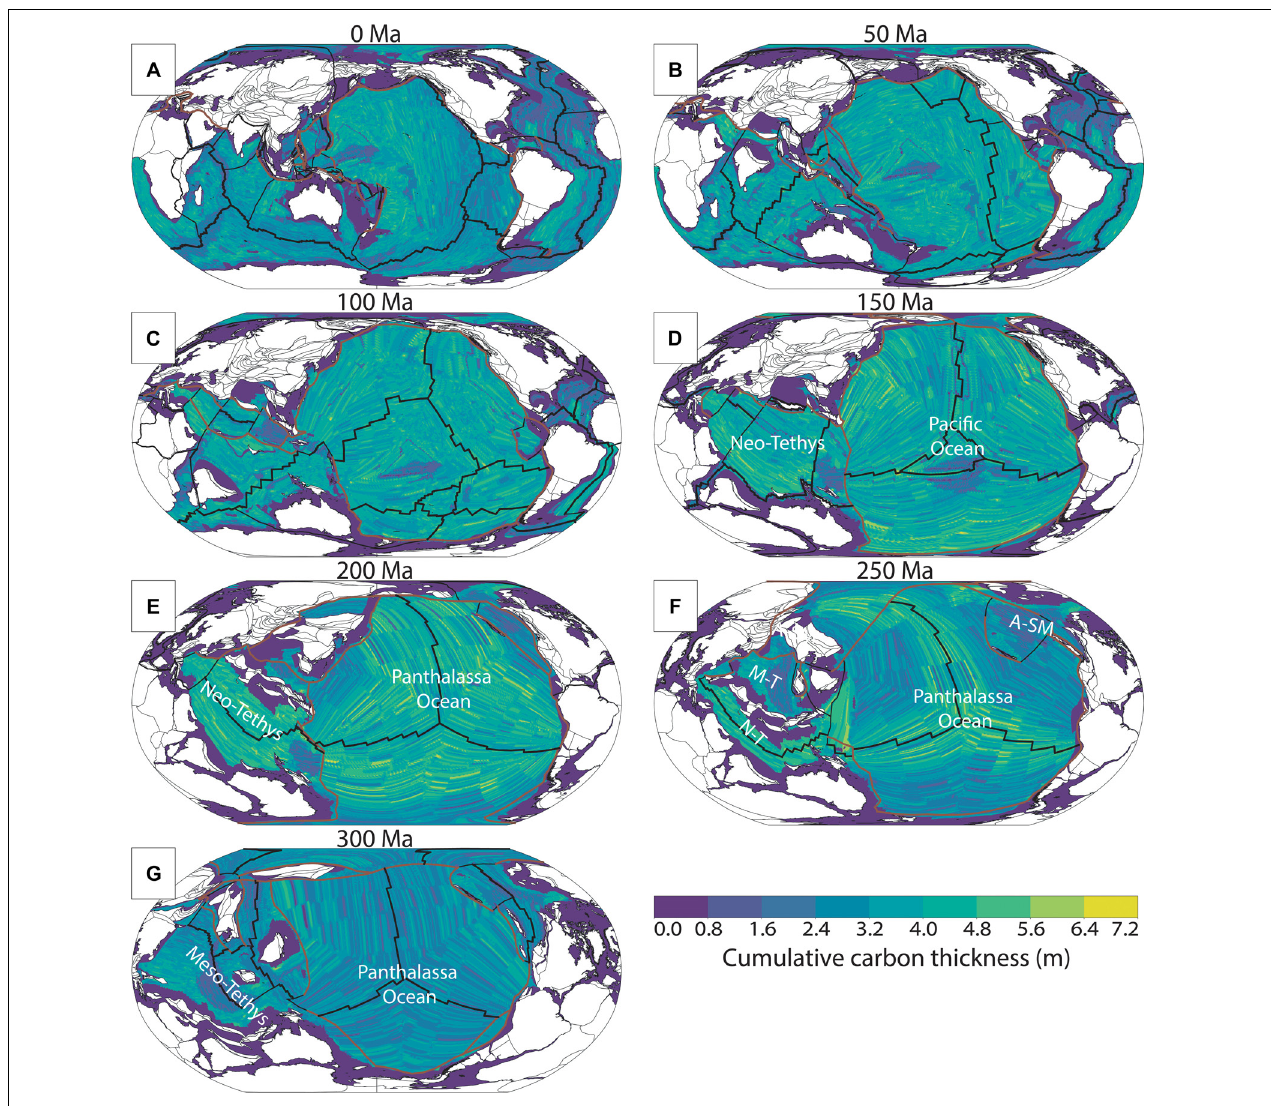
FIGURE 8 | (A–G) Cumulative thickness of carbon sequestered adjacent to mid-ocean ridges and transported in the upper oceanic lithosphere through ocean basins toward subduction zones since 300 Ma in 50 Ma intervals (see Supplementary Material 3 for 1 Ma grids and rasters and Supplementary Material 5 for an animation). Thicknesses calculated prior to 160 Ma are converted from vertical area to point thickness. A-SM, Alexander-Stoney Mountain ocean basin; M-T, Meso-Tethys Ocean; N-T, Neo-Tethys Ocean. Purple areas represent lithosphere not covered by our analysis or the plate model, such as submerged continental lithosphere or lithosphere trapped between a continent and a subduction zone (principally in the Palaeozoic), which would represent earlier (pre-400 Ma) oceanic crust. Black lines are mid-ocean ridges, brown lines are subduction